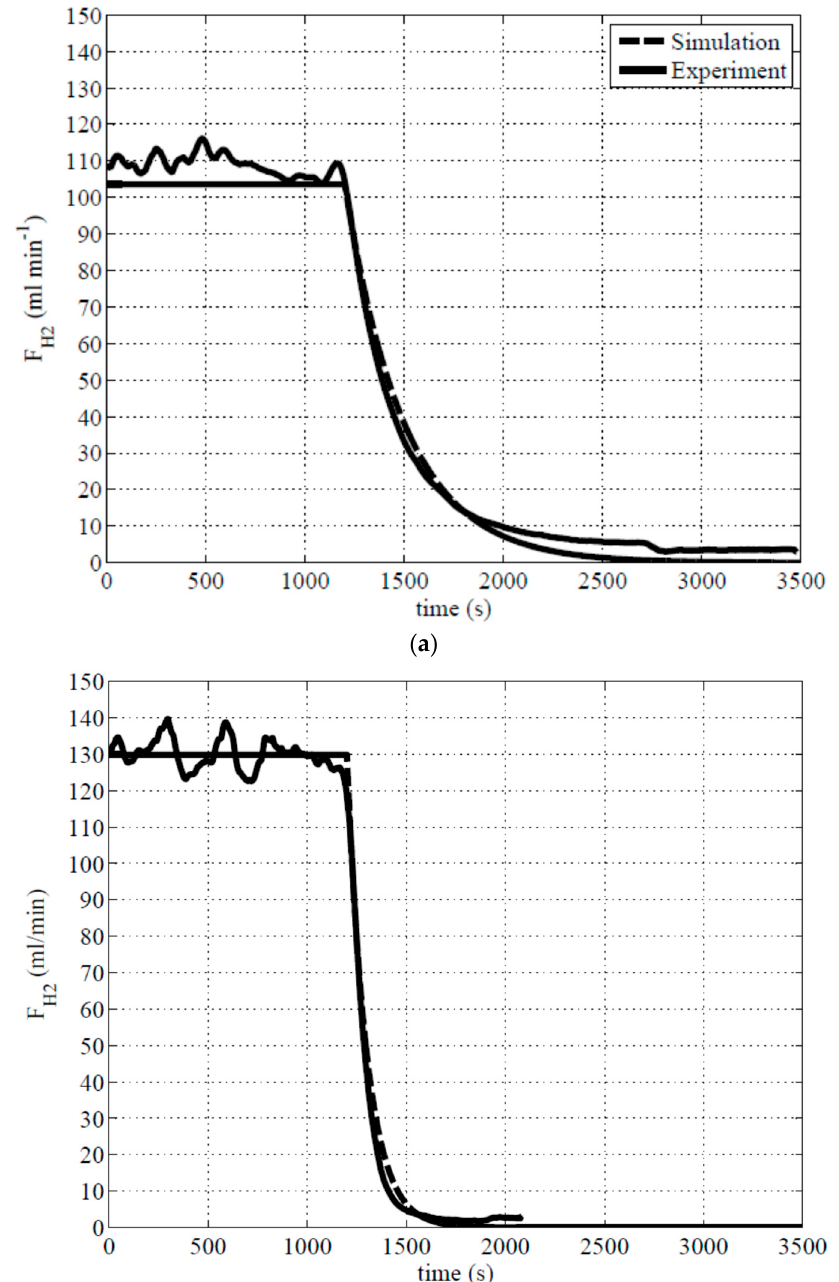
Figure 6. Dynamic response of the hydrogen flowrate at ( a ) 40 °C, ( b ) 70 °C.